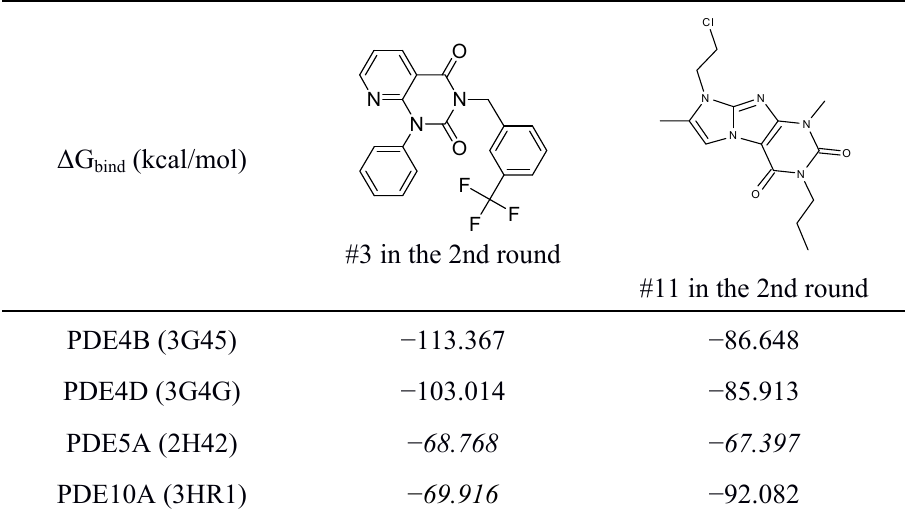
energies obtained from MM-GBSA calculation for various PDE Table 6. Δ G bind